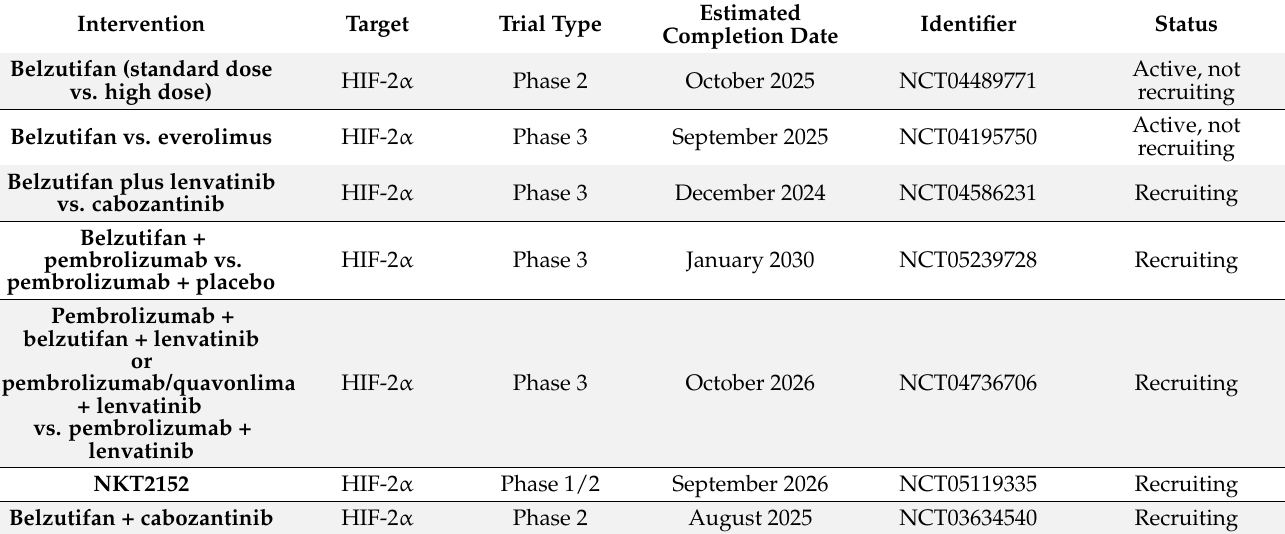
Table 3. Ongoing Clinical Trials of Hypoxia-Inducible Factor-2 α